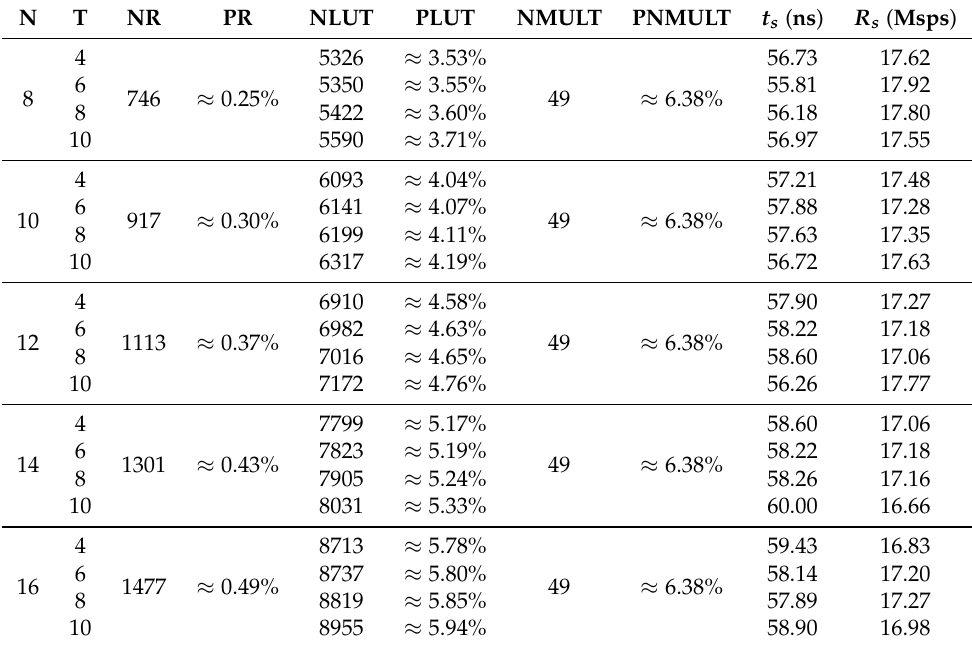
Table 2. Synthesis results (hardware requirement and time) associated with TS-FIMM-P